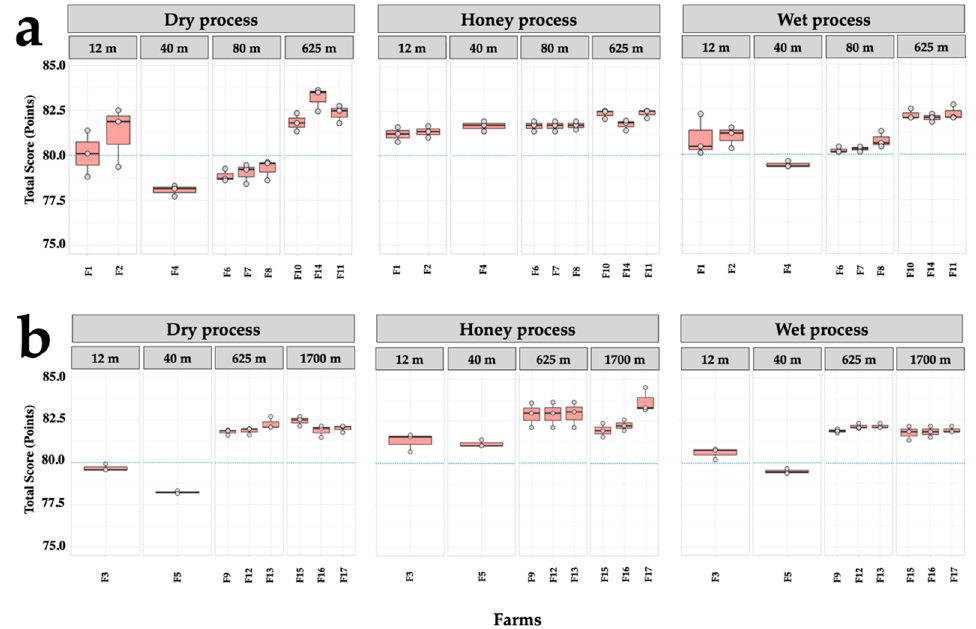
Figure 3. Total score of congolensis 100-point scale at different altitudes and different post-harvest processes, where: ( a ) congolensis; ( b ) conilon.